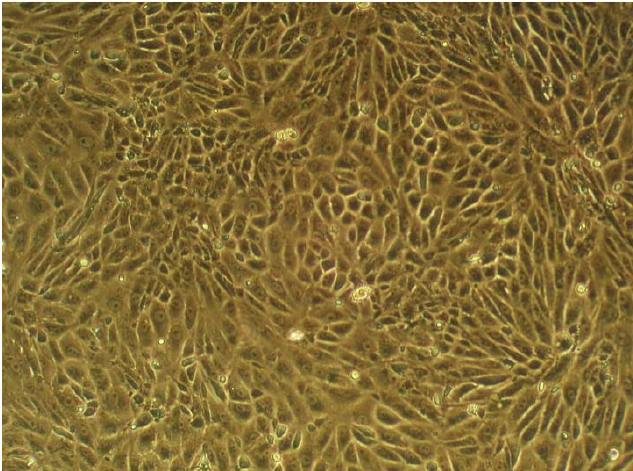
Figure 1. Phase contrast of choroid plexus cells grown on Thermanox for 4 days. The cells form a monolayer displaying a polygonal shape. The culture was previously treated with cys-arabinoside to eliminate cell contamination. 20X